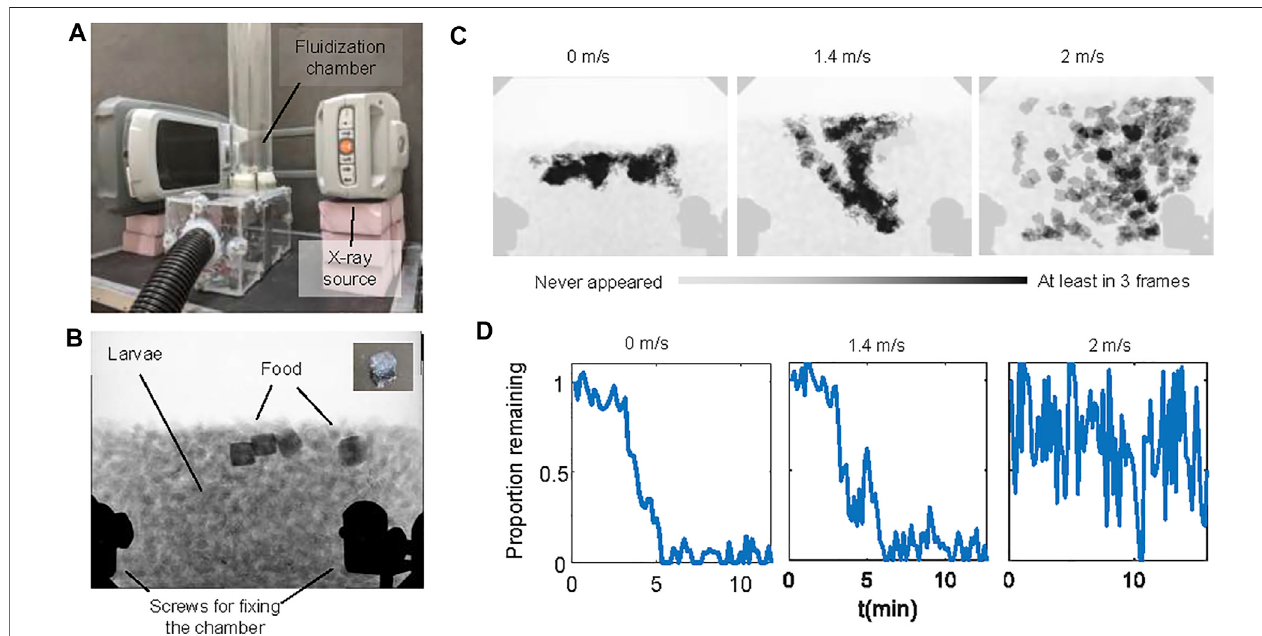
FIGURE 6 | Larva feeding experiments with cubic jellies. (A) The experimental setup for the feeding experiment consists of the fl uidization chamber and a portable x-ray machine. (B) A representative X-ray image of the experiment. Darker regions near the top of the aggregations are food. The inset shows a picture of the cube- shaped jelly. The black shades near the bottom of the image are the screws of the chamber. (C) The spatial distribution of the food using time-lapse photography. Light gray showsthatthefoodnever appeared inthelocationthroughoutthevideo.Blackshowsthatthefoodappeared at leastinthreevideoframes. (D) Time seriesof the proportionof food remaining in the chamber under no fl ow, slow fl ow, and fast fl ow conditions. Larvae used in here aremedium size(see the Materials and Methods